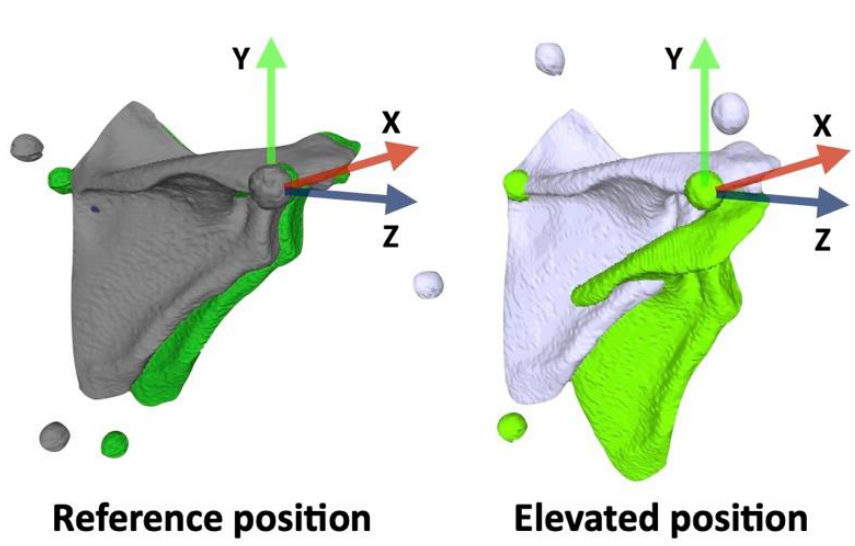
Figure 5. The scapular rotation was evaluated by bone-based (gray and white) and marker-based (dark green and light green) scapula coordinate systems.